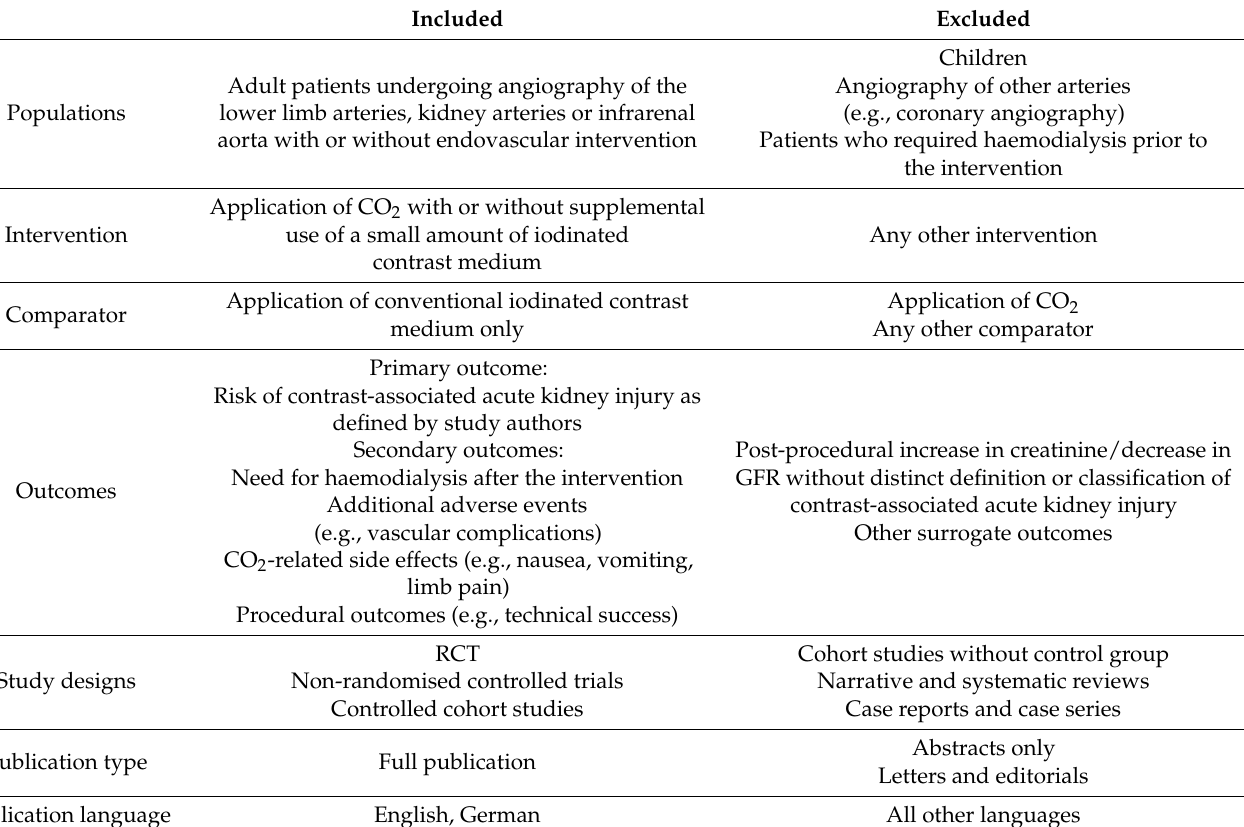
Table A1. Study eligibility